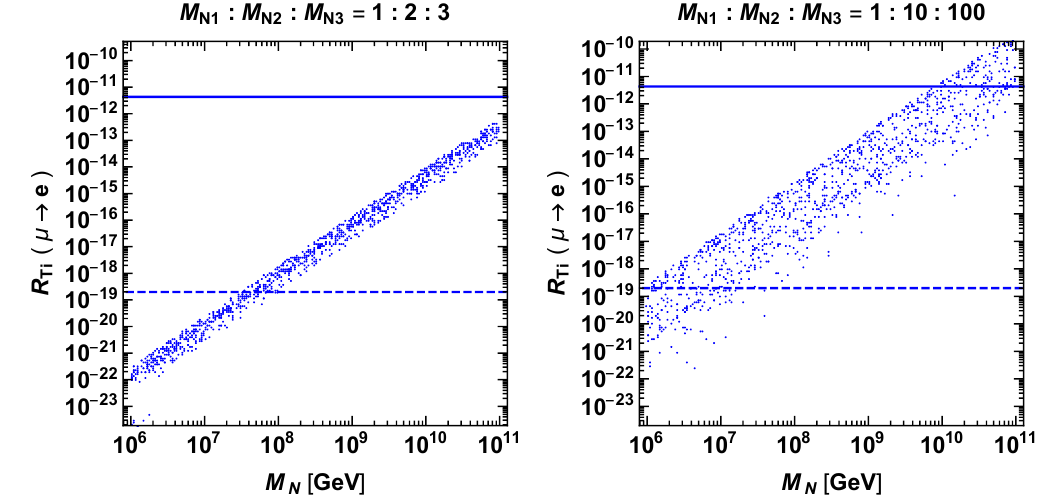
Figure 13 . R Ti ( µ → e ) is shown for the model C . The parameters are same as figure